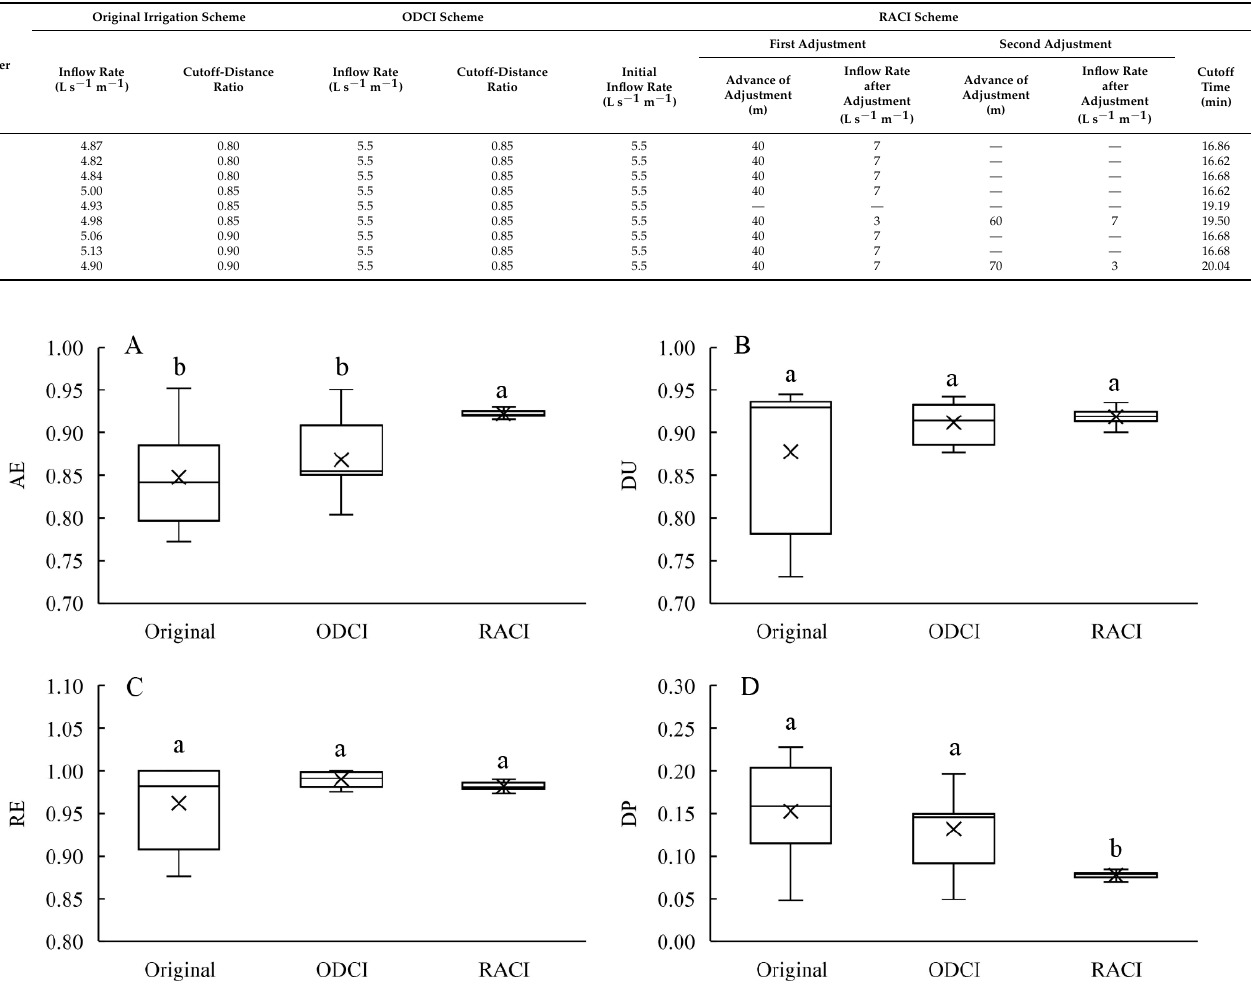
Figure 2. Boxplots illustrating the ( A ) AE, ( B ) DU, ( C ) RE, and ( D ) DP of each scheme. Boxplots labeled with different letters indicate significant differences at p = 0.05, based on the Duncan test.